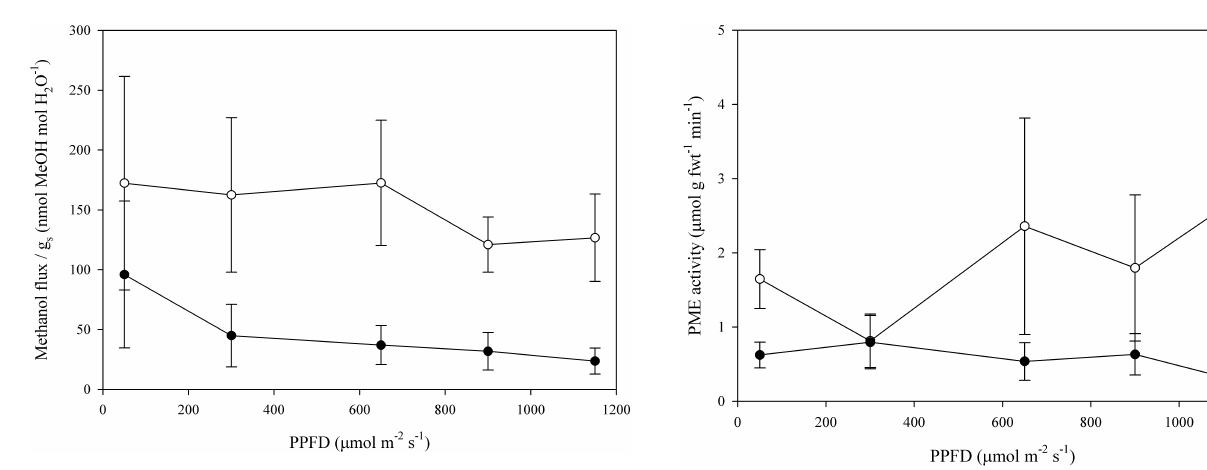
Fig. 4. Average PME activity rates over five light levels for n = 5 mature (black circles) and immature (white circles) L. esculentum (standard error bars shown). PPFD had no significant effect on en- zyme activity ( F = 0 . 40 df = 4 P = 0 . 81). Plant type had a signifi- cant effect on PME activity overall ( F = 14 . 46 df = 1 P = 0 .